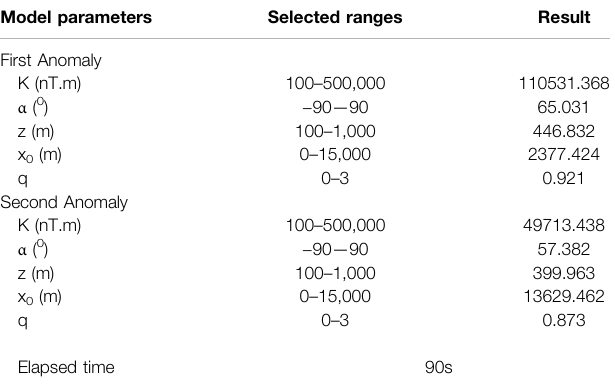
TABLE 10 | Numerical Results for the Hamrawein fi eld anomaly. Model parameters Selected ranges Result